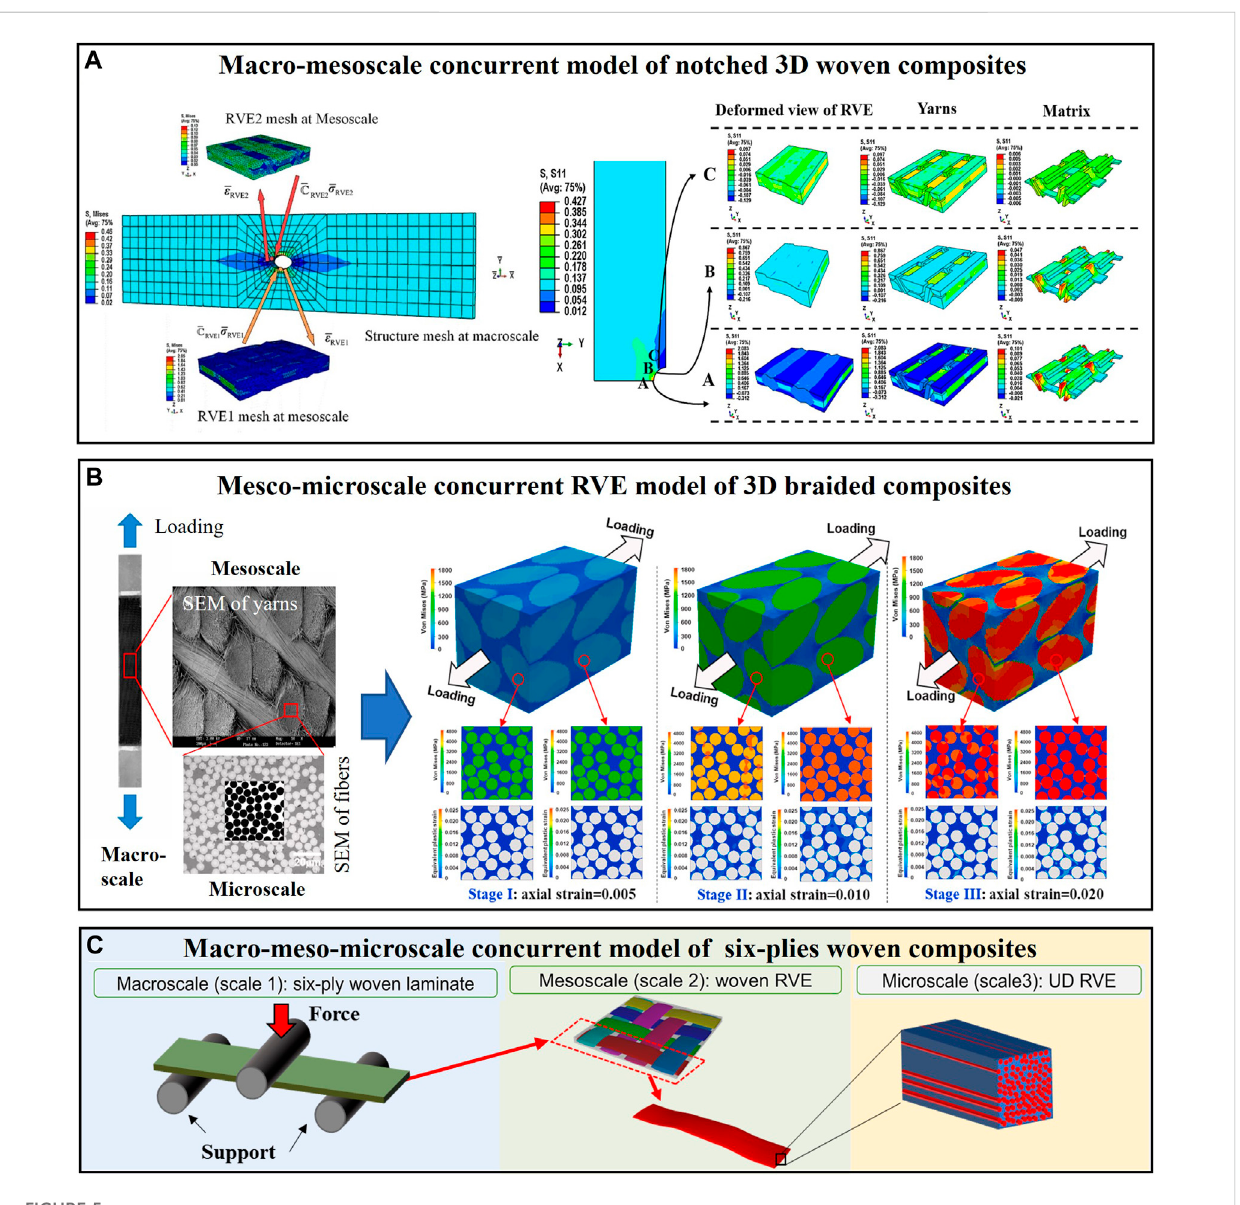
FIGURE 5 Concurrent multiscale models of composites (A) Macro-mesoscale (Qiao et al., 2023), (B) Meso-microscale (He et al., 2021), (C) Macro-meso- microscale (Gao et al., 2022).